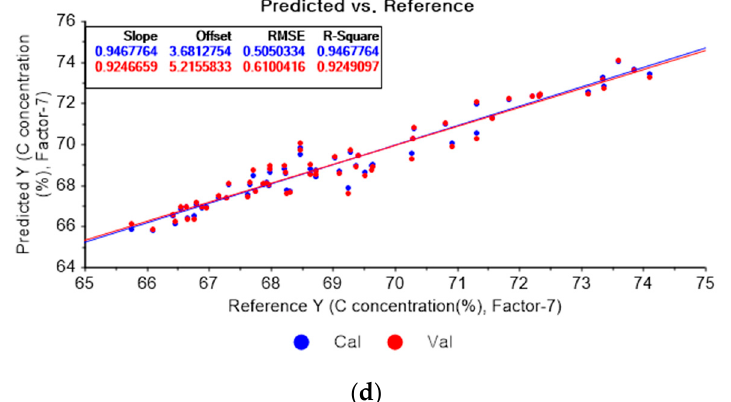
Figure 4. PLSR model of carbon concentration with ( a ) original data and PLSR models pre-processed with SG smoothing by adopting ( b ) fourth-order polynomial with three points, ( c ) fourth-order polynomial with five points, and ( d ) fourth-order polynomial with seven points.